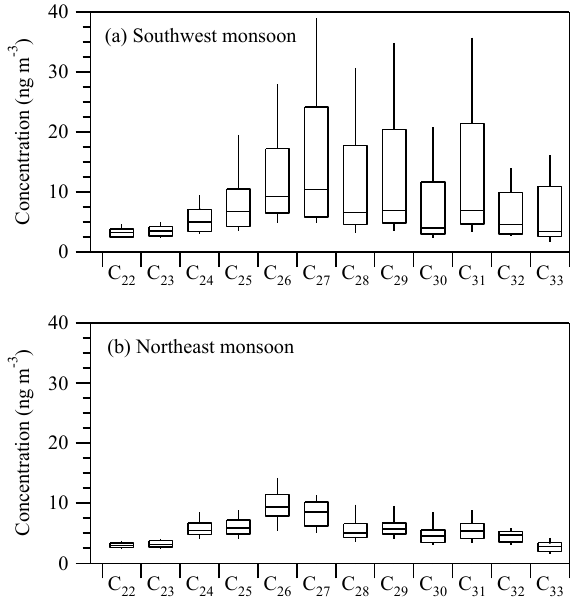
Figure 4. Box-and-whisker plots of molecular distributions of n - alkanes during the (a) southwestern and (b) northeastern monsoon seasons. The horizontal lines in the box represent the 25th, 50th and 75th percentiles. The whiskers represent the 10th and 90th per-